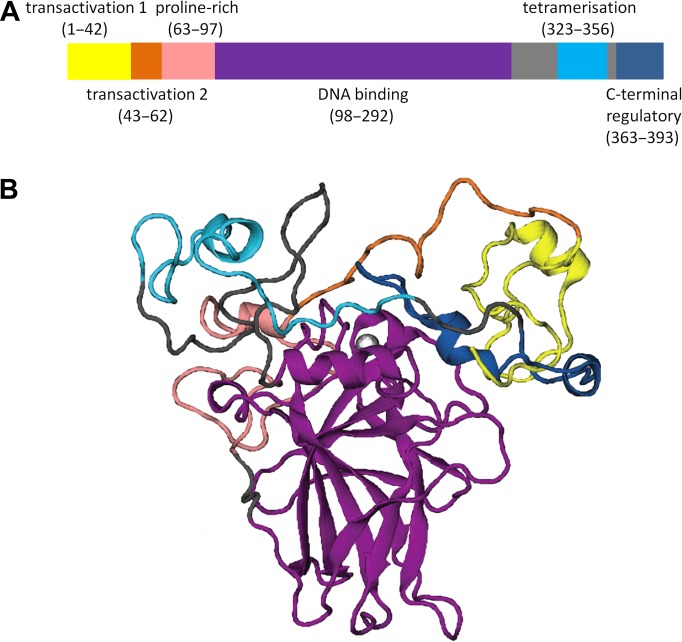
The p53 architecture. (A) Domain architecture of p53. (B) The modelled full-length structure of p53 (Chillemi et al., 2013). Reprinted by permission of Taylor & Francis Ltd.